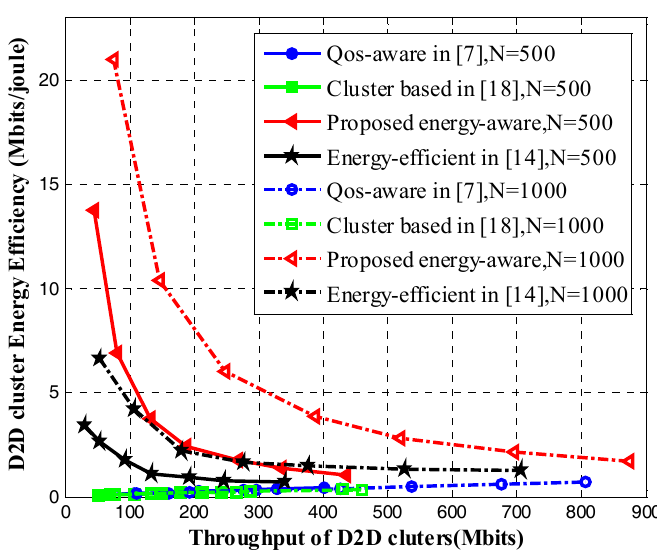
Figure 4. D2D Group Energy Efficiency versus throughput.